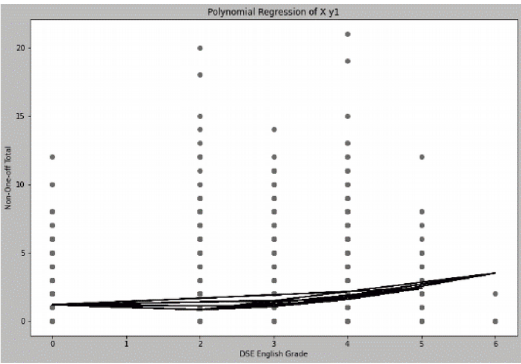
Figure 19. Polynomial Regression of X y1 in Finding 3